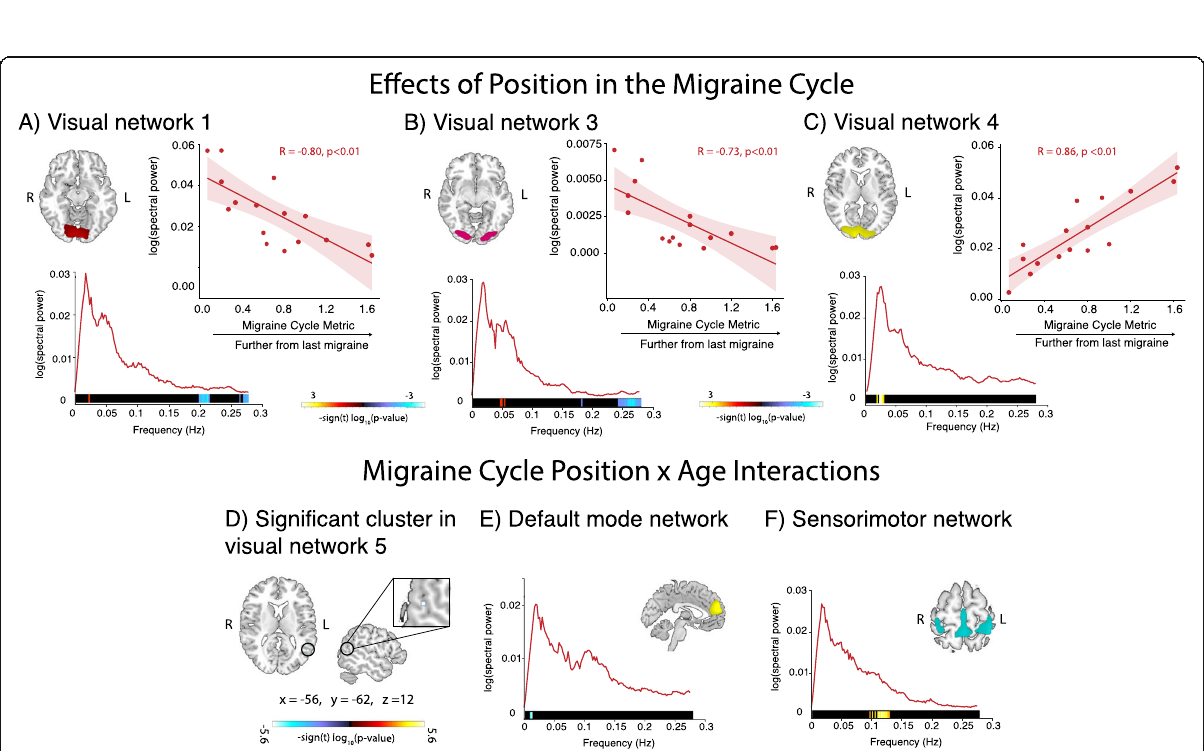
Fig. 5 Location in the migraine cycle and location by age interaction effects on connectivity. a Power spectra from visual network 1, frequencies which significantly correlated with the migraine cycle metric are highlighted at the bottom. Example of negative correlation between log (spectral power) at 0.20 Hz and position in the migraine cycle is shown. b Power spectra from visual network 3, frequencies which significantly correlated with migraine cycle metric are highlighted at the bottom. Example of negative correlation between log (spectral power) at 0.26 Hz and position in the migraine cycle is shown. c Power spectra from visual network 4, frequencies which significantly correlated with migraine cycle metric are highlighted at the bottom. Example of positive correlation between log (spectral power) at 0.02 Hz and position in the migraine cycle is shown. d Cluster in the lateral occipital cortex exhibiting significant group by pubertal status interaction effects on connectivity within visual network 5 (number of voxels= 11). e Power spectra from the default mode network, frequencies where significant position by age interactions were present are highlighted at the bottom. f Power spectra from the sensorimotor network, freqeuncies where significant position by age interactions were present are highlighted at the